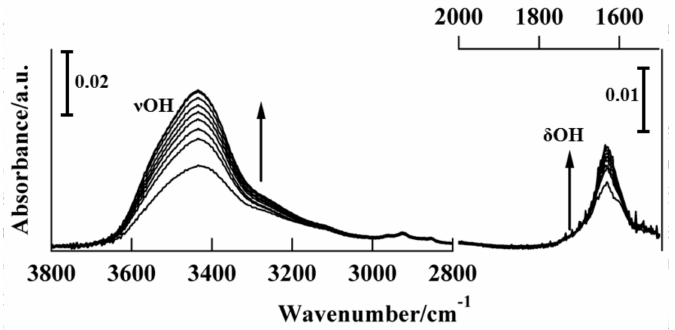
Figure 4. Time-course variations of absorption FT-IR spectra for water adsorption on a KBr disk (15-min intervals). The arrows indicate the direction of the spectral intensity evolution with time.